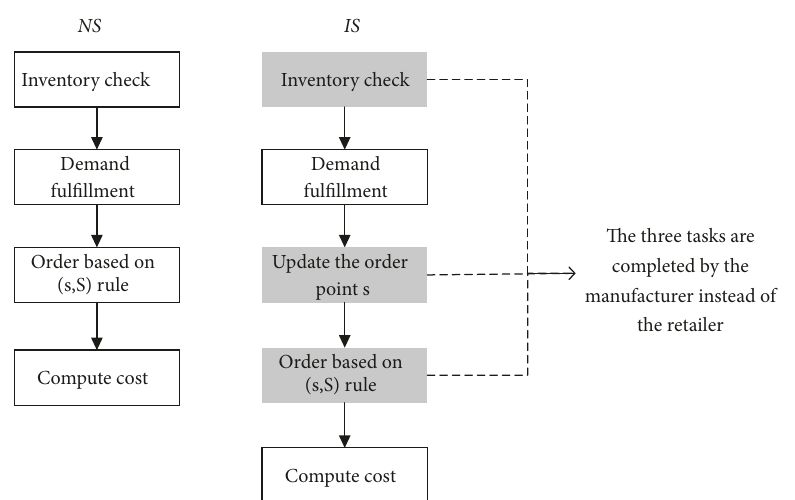
Figure 2: The retailer’s behavior under two